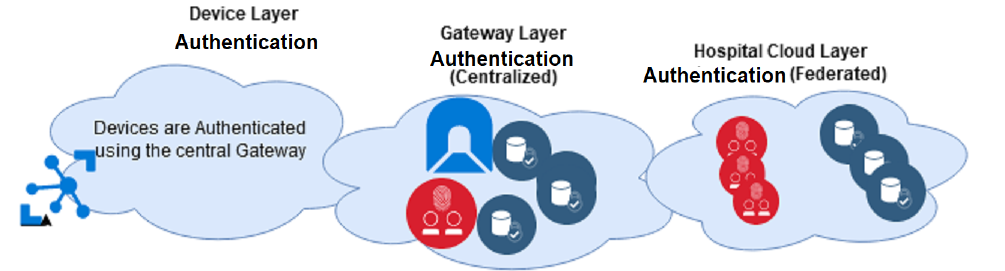
Figure 3. The architecture for the proposed IDMS for PH.